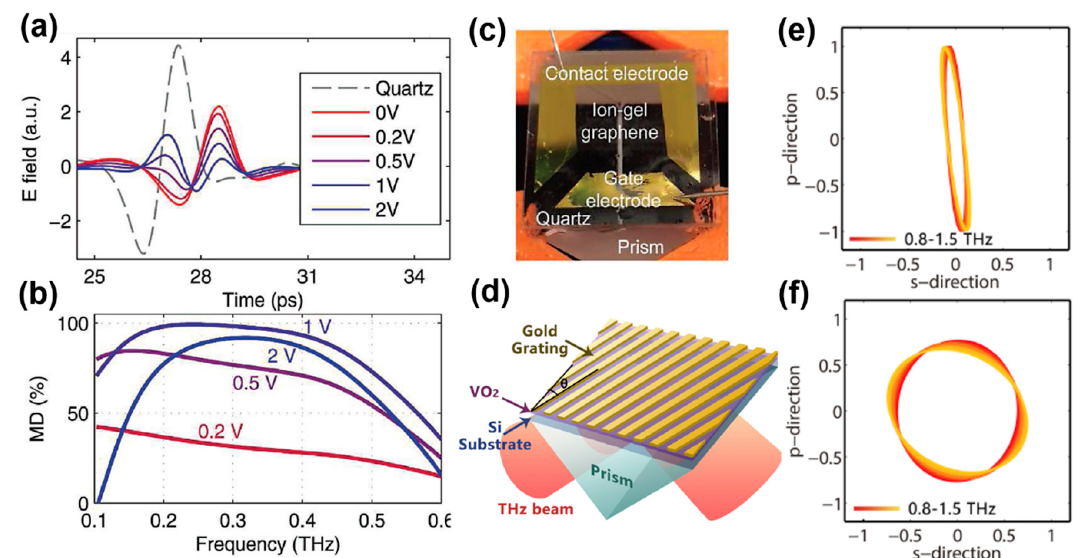
Figure 2. Illustration of the THz wave modulation geometries and devices and results. ( a ) Time-domain results for the quartz reference and the ion-gel graphene-on-quartz with different voltages. ( b ) Modulation depth (MD) from 0.1 to 0.6 THz as a function of gate voltage. ( c ) The ion-gel graphene-on-quartz device. ( d ) The VO 2 device and its combination with the prism. The polarization states from 0.8 to 1.5 THz, when the VO 2 was in ( e ) insulating and ( f ) metallic states, respectively. Reproduced with permission from [28], Copyright © 2016, WILEY-VCH VERLAG GMBH &